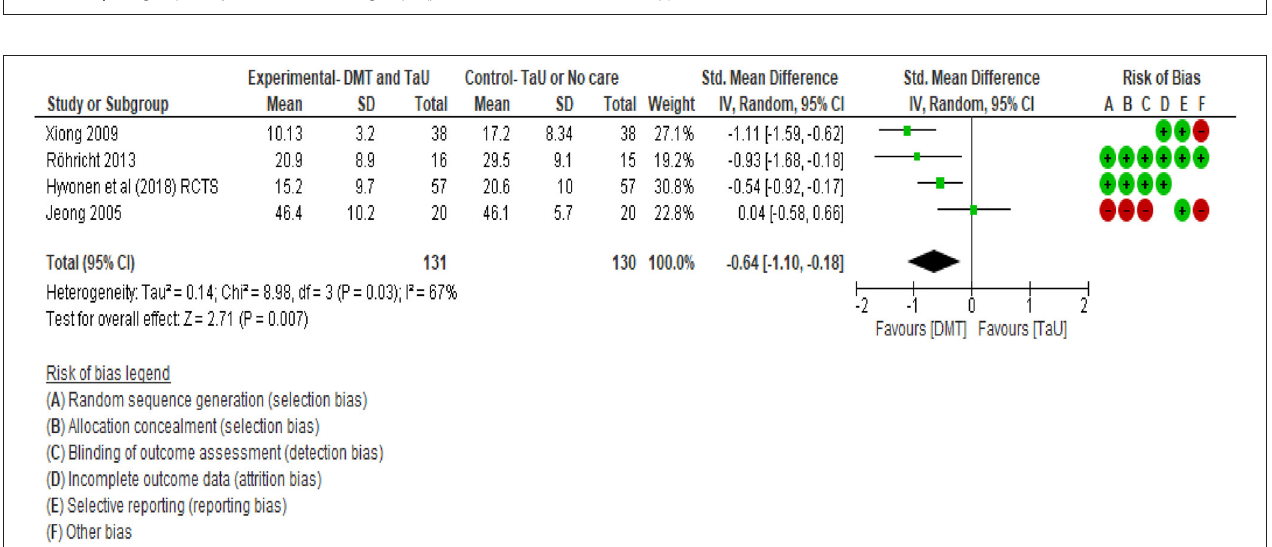
FIGURE 7 | Subgroup analysis for within DMT groups (pre DMT vs. 3 months follow up).